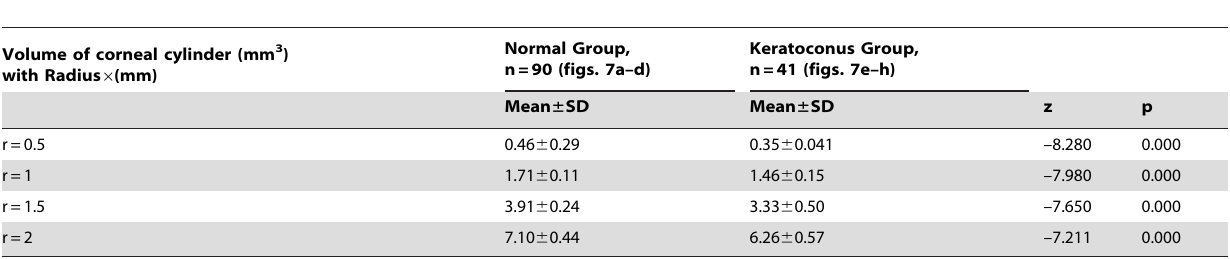
Table 2. Differences between the normal group (Figs. 7a–d) versus the keratoconus group (Figs. 7e–h) in the volume of corneal cylinder with radius 0.5, 1.0, 1.5 and 2.0 mm (mean and standard deviation; U-Mann-Whitney-Wilcoxon test).